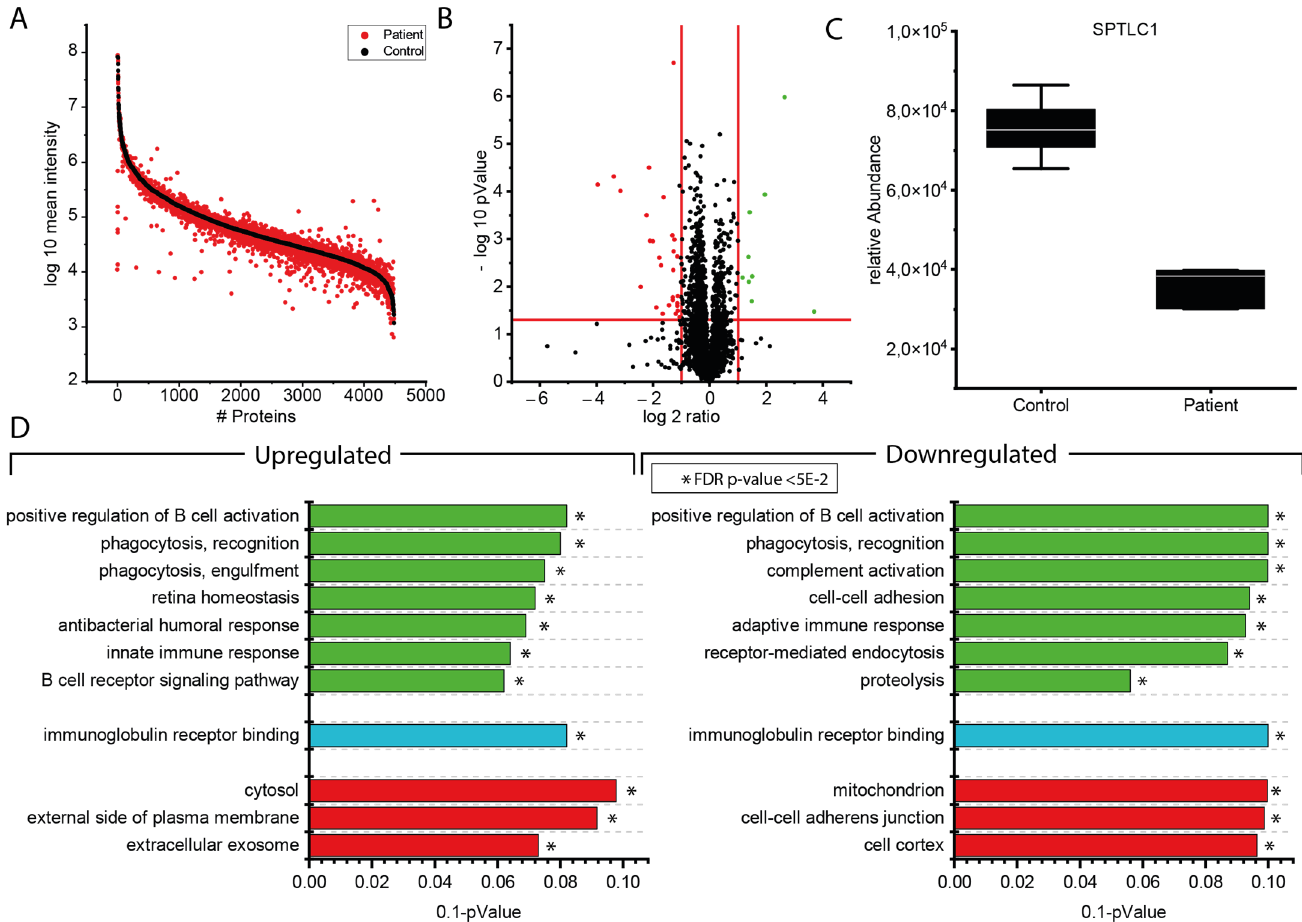
Figure 2. Proteomic findings in immortalized lymphoblastoid cells derived from the p.(A20S)- SPTLC1-patient: ( A ) Protein enrichment plot along the entire abundance range. Proteins highlighted in black represent the control results, sorted by abundance. Proteins highlighted in red represent the abundance of the patient proteins, left in the same order as the control proteins to highlight differences in their expression. ( B ) Volcano-plot of proteomic findings. Red dots represent proteins demonstrating a significant decrease whereas green dots represent proteins with a significant increase in abundance. Red lines indicate the significance thresholds of p -value 0.05 ( y -axis) and 2-fold increase or 0.5-fold decrease in abundance ( x -axis). ( C ) Boxplot depicting the relative abundance of the SPTLC1 protein comparing control- and patient-derived samples. ( D ) GO-term based pathway analysis for up- and downregulated biological processes (green), molecular functions (blue), and cellular compartments (red) which are significantly regulated by comparing control and patient samples. Terms are sorted from top to bottom with decreasing level of significance. To achieve a better representation, the x -axis is given as 0.1 p -value (* = statistically significant).